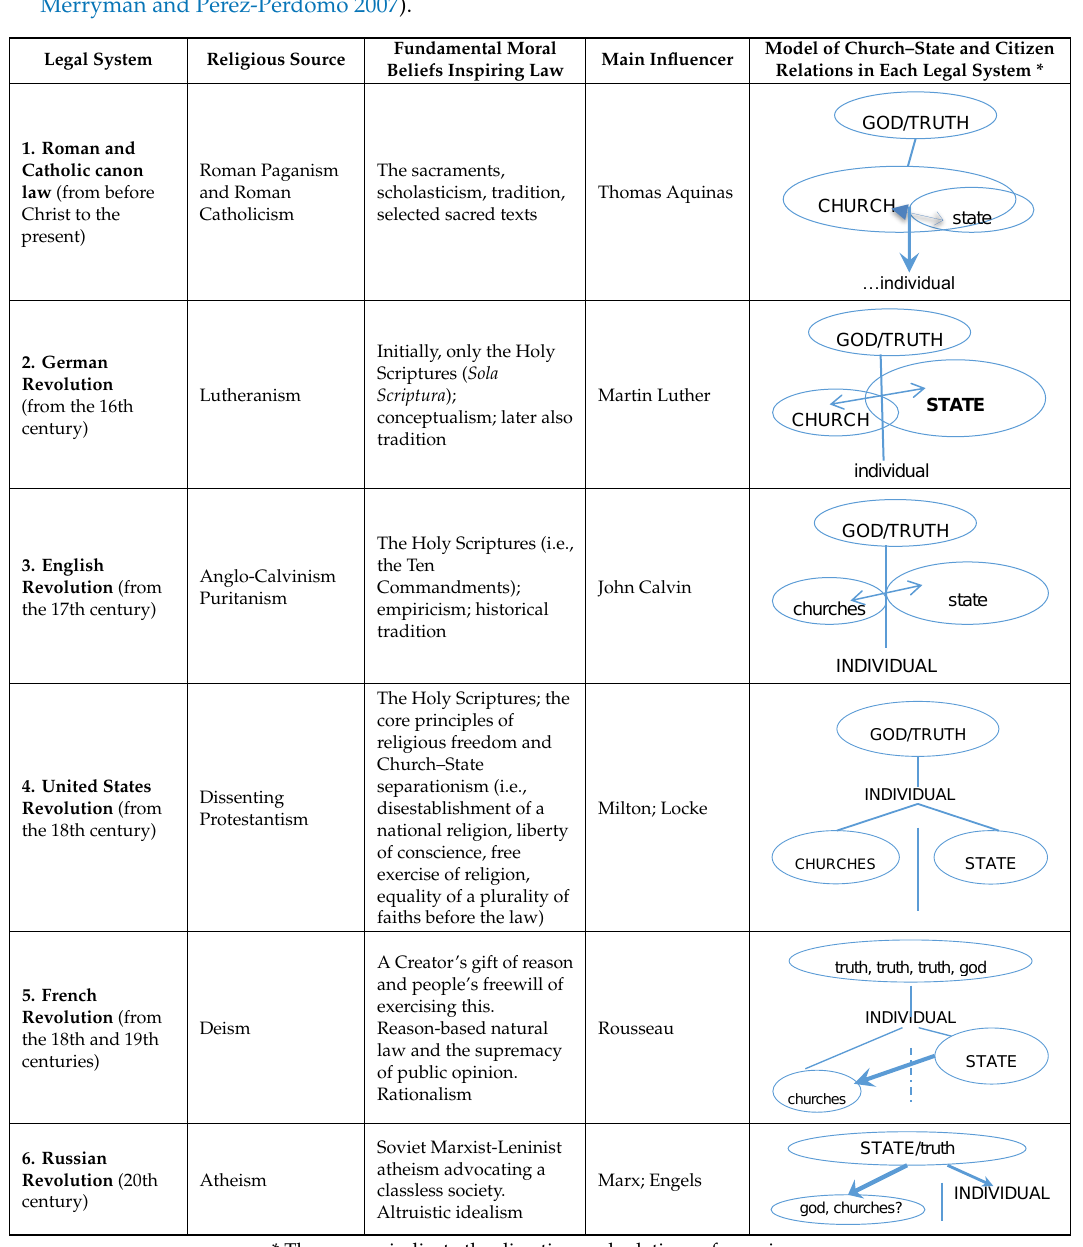
* The arrows indicate the direction and relations of coercion.